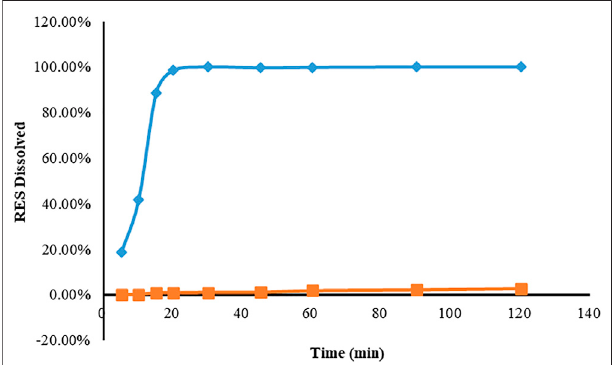
FIGURE 2 | Dissolution pro fi les of resveratrol ( ■ ) and inclusion complex ( ◆ ) in normal saline after 120 min. The results were expressed according to the mean and standard deviation (n (cid:1) 3) of the